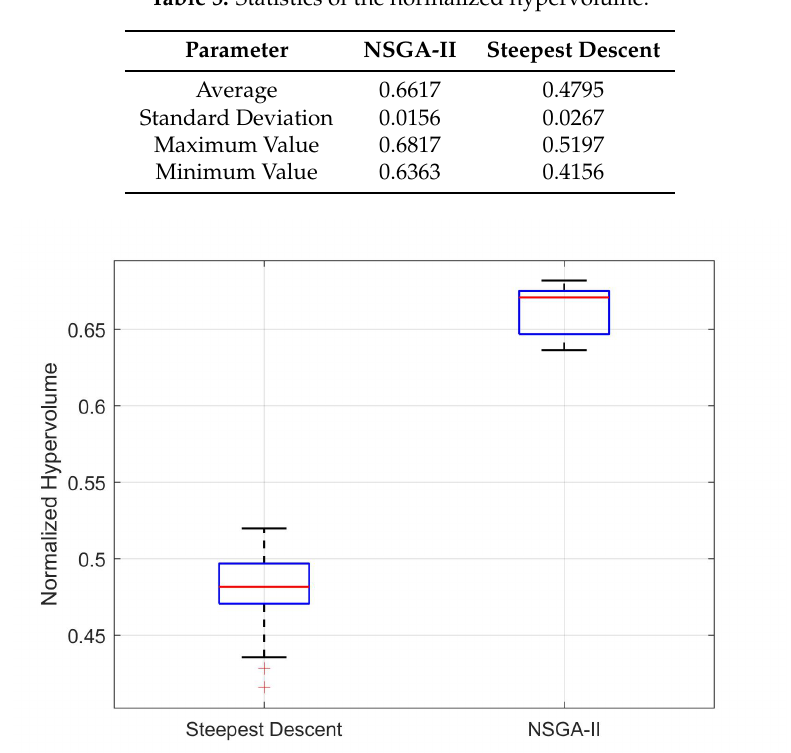
Table 5. Statistics of the normalized hypervolume.